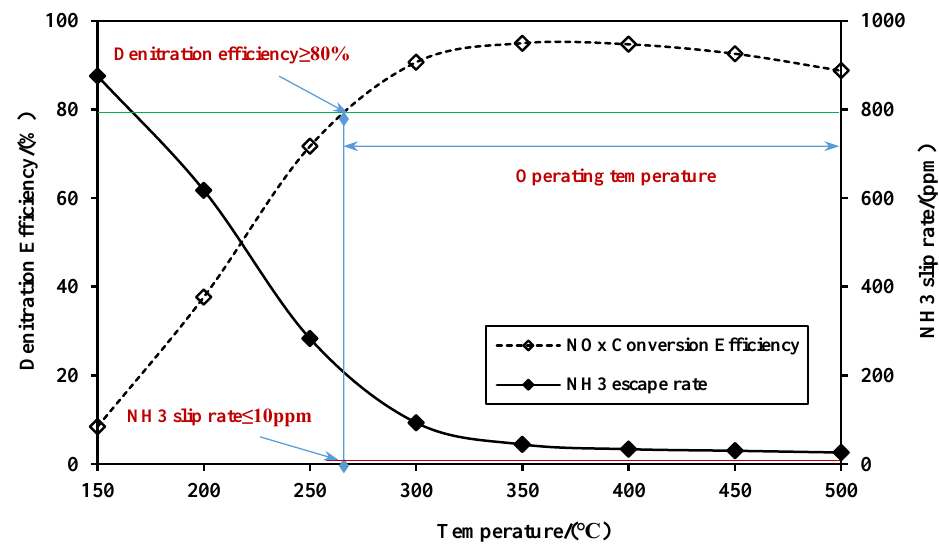
Figure 1. Effect of exhaust gas temperature on the denitration efficiency and the ammonia slip.